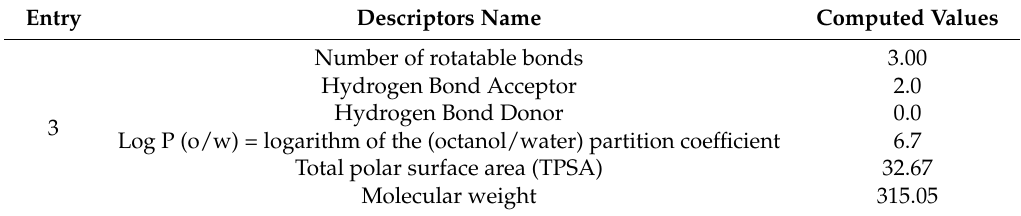
Table 2. Descriptors computed for compound 3